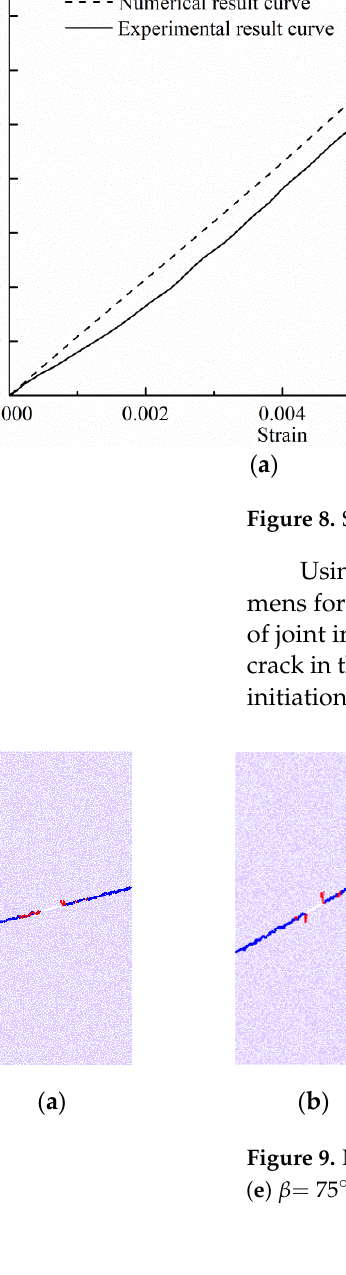
( e ) Figure 10. Numerical results of granite specimens: ( a )